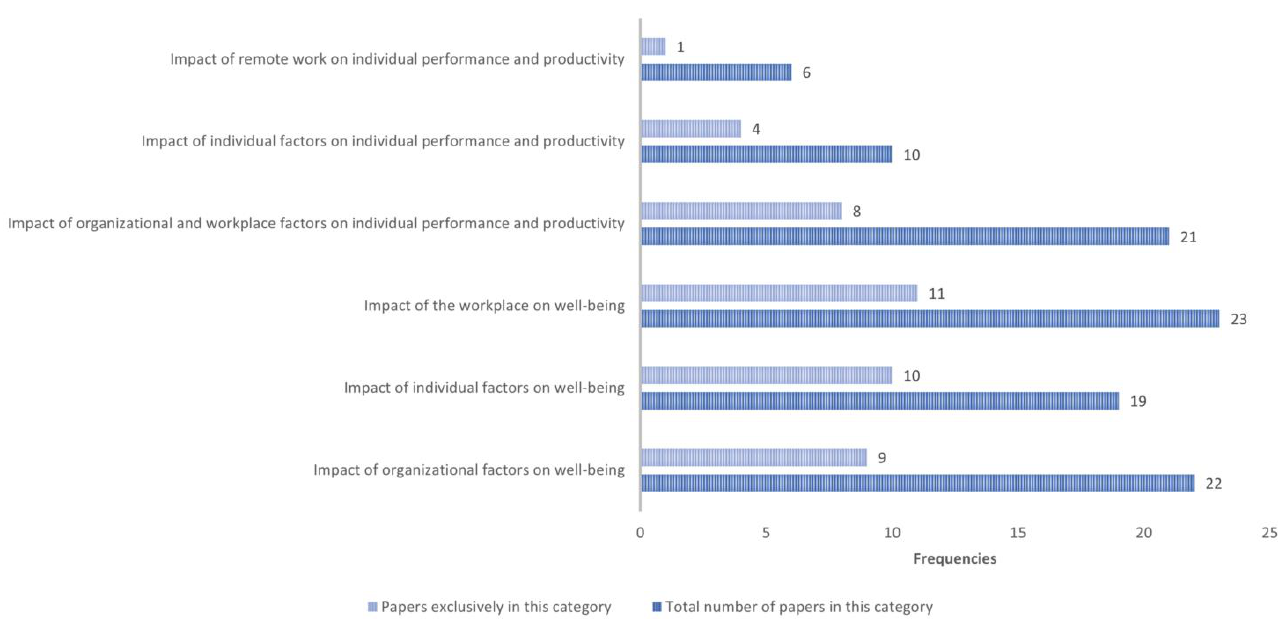
Figure 2. Papers distribution across categories.